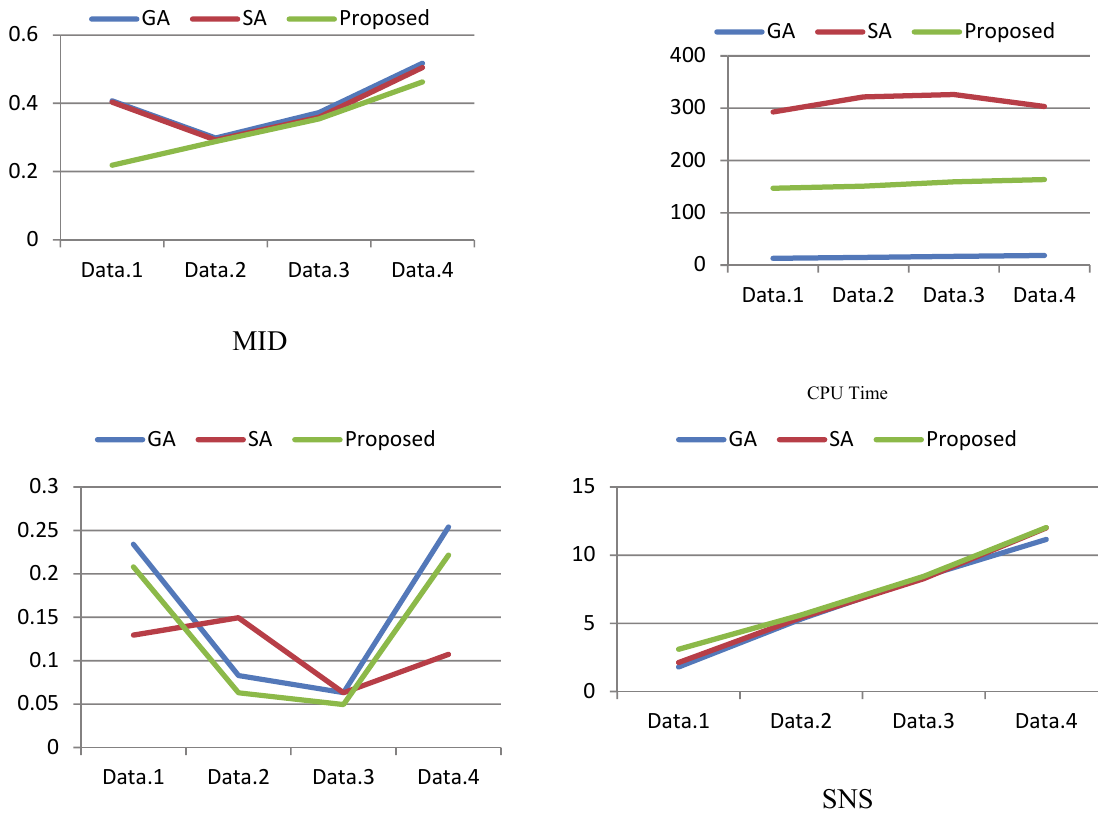
Fig. 8. The summary of the performance of the proposed method in terms of MID, CPU Time, SM and SNS metrics based on different data